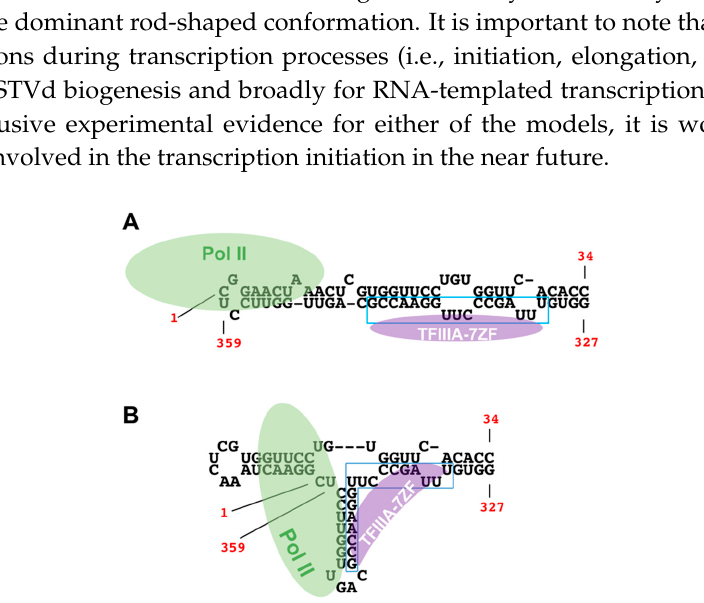
Figure 2. Two possible left terminal conformations during replication. ( A ) Traditional rod-shape left terminal conformation; ( B ) Alternative bifurcated left terminal conformation. The mapped TFIIIA-7ZF binding region is highlighted in a blue box.